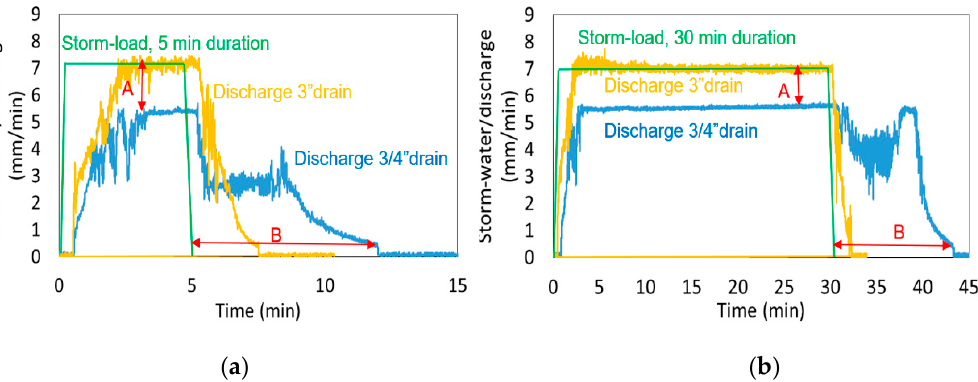
Figure 8. Roof Integrated Design with two drain diameters and a storm ‐ load with 5 min ( a ) and 30 min ( b ) durations.